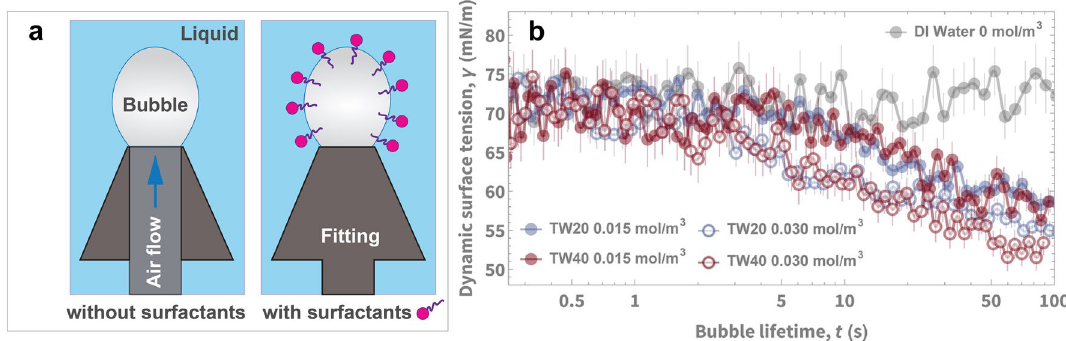
Figure 6. Surfactants with different CMCs and equilibrium surface tensions have similar dynamic adsorption behaviors at short time scales when at the same concentration. We performed ( a ) dynamic pendant bubble experiments to measure, using Young–Laplace fitting, ( b ) time-dependent surface tension of two surfactants: TW20 and TW40 at room temperature (25 °C) were used for testing at two different surfactant concentration amounts in DI water. The CMCs of TW20 and TW40 are 0.05 mol/m 3 and 0.02 mol/m 3 , respectively. At 0.015 mol/m 3 the equilibrium surface tensions are 47.66 ± 0.08 mN/m and 43.99 ± 0.09 mN/m, respectively. At 0.03 mol/m 3 the equilibrium surface tensions are 44.22 ± 0.09 mN/m and 42.55 ± 0.01 mN/m, respectively.